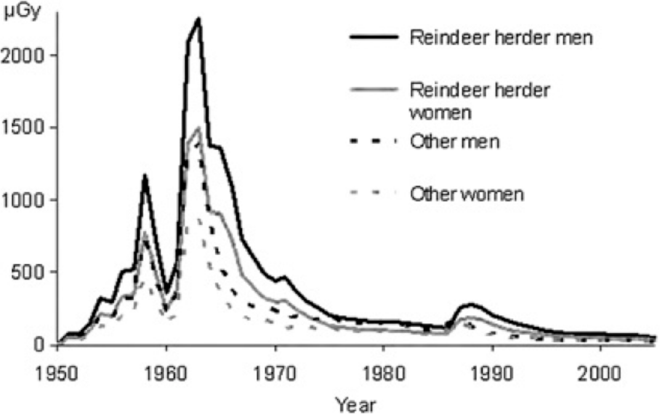
Figure 3. 137 Cs body burden in Inari population from 1965 to 2013 [29]. After the mid-1960s, 137 Cs activity concentrations in reindeer meat decreased, and an effective ecological half-life of about 5–10 years was observed until the Chernobyl accident in 1986.